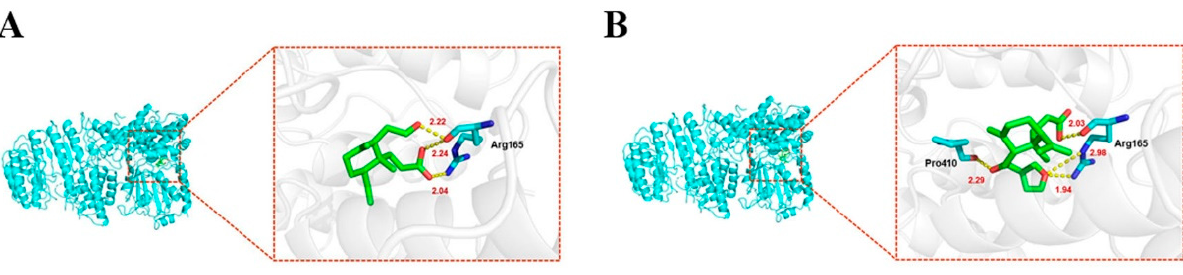
Molecules 2021 , 26 , x FOR PEER REVIEW 9 of 14 Figure 9. Anti-inflammatory activities of compounds 1 and 2 obtained from CNE-p.